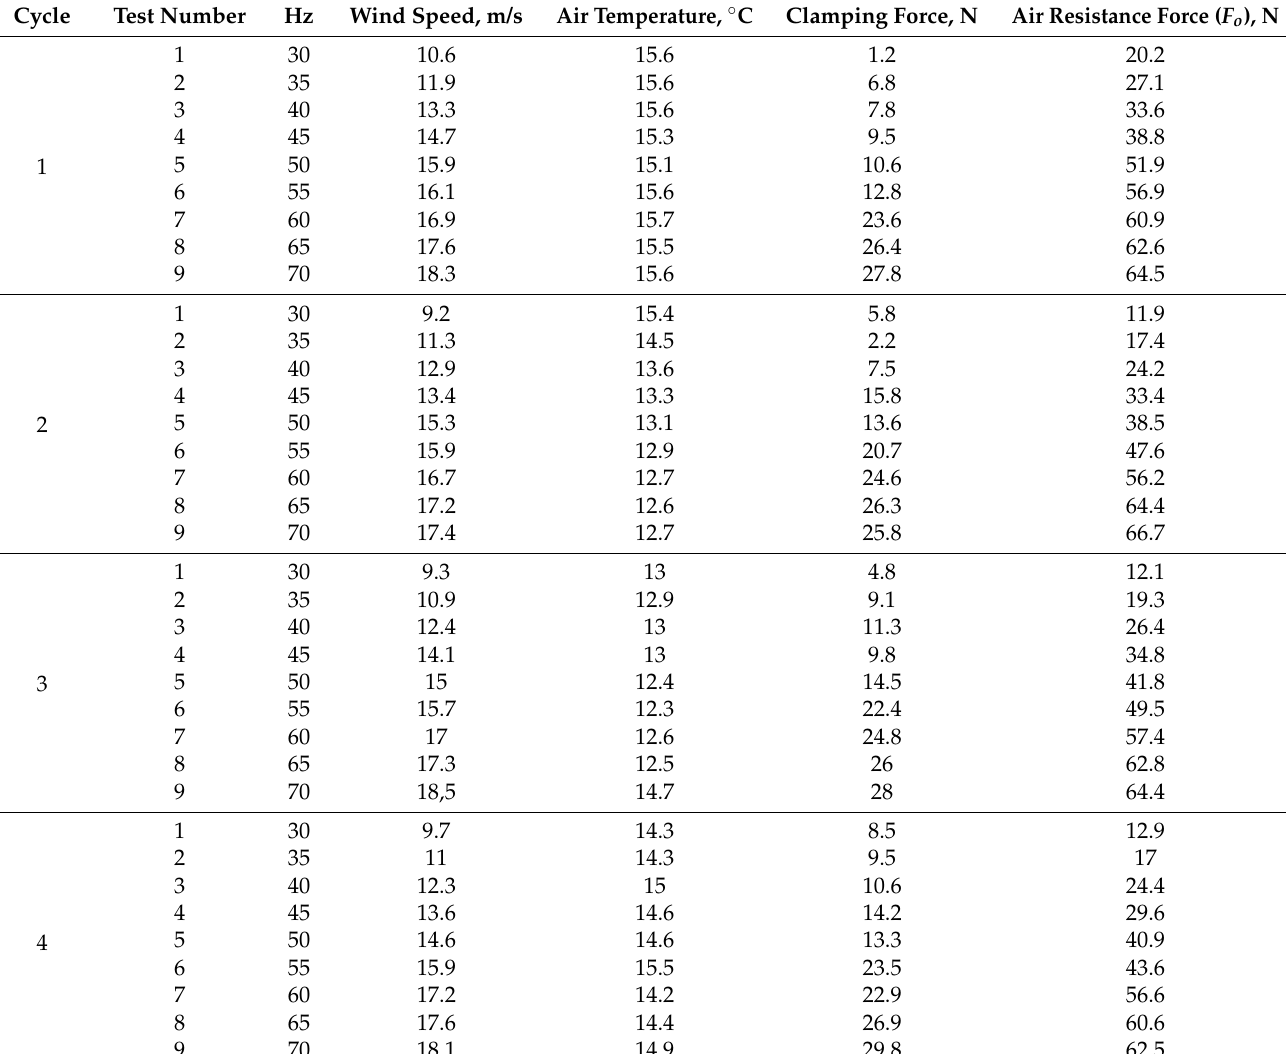
Table 2. Air resistance measurements